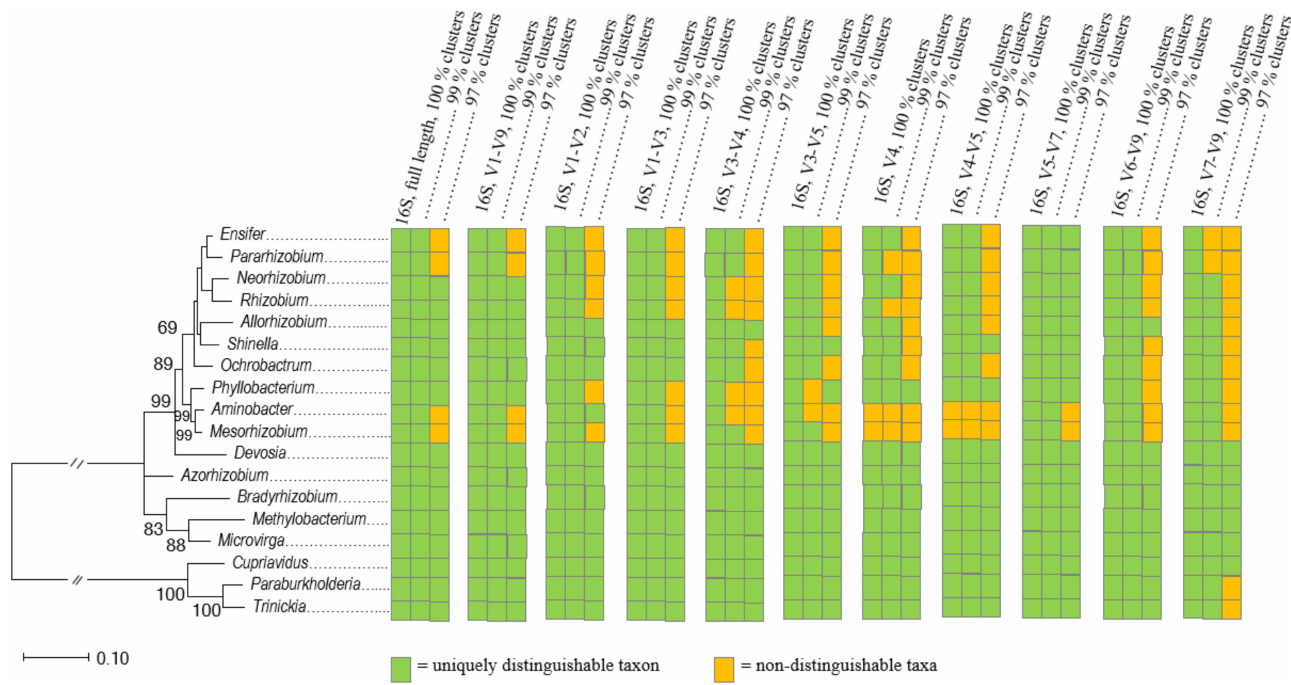
Figure 7. An unrooted phylogenetic tree based on the full-size sequence of the 16S rDNA (1564 positions), using the Maximum Likelihood method and Tamura-Nei model using a discrete Gamma distribution with invariant sites (TN93+G+I). Bootstrap values ≥ 70% based on 1000 replicates are indicated, and the scale bar represents the number of substitutions per site. A green shaded box indicates that a taxon can be uniquely distinguished with the given V-region and gene length and clustering method, while an orange box indicates that a taxon is merged with at least one other taxon in at least one gene